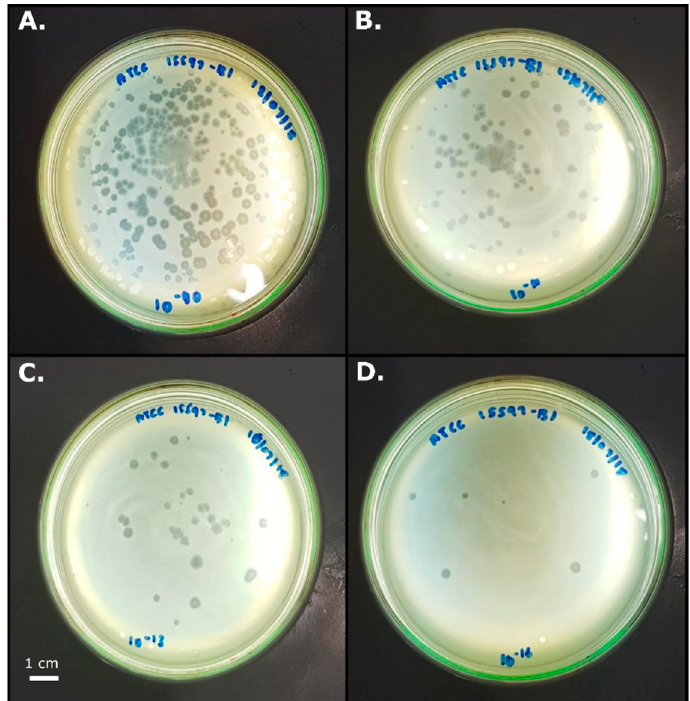
Figure 5. Time-based efficiency against drive current for UV-LED bench- and full-scale reactor.